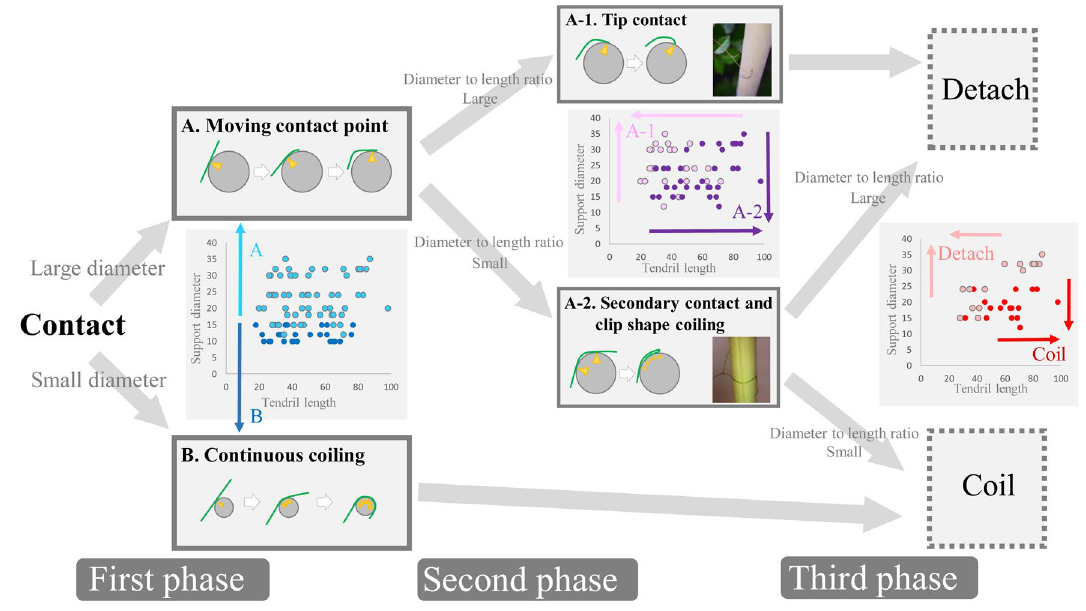
Figure 2. Phase pattern of coiling response. Temporal change in coiling response with three steps was obtained from direct observation. The illustrations and pictures in the frame represent typical examples of the coiling form in each step. For the illustration, green line represents the shape of the tendrils and yellow triangles represents the contact points between the tendrils and the supports. Three scatter plots represent the effects of tendril length and support diameter on the results of the phase pattern. The left, centre, and right plots represent the results of first, second, and third phases,